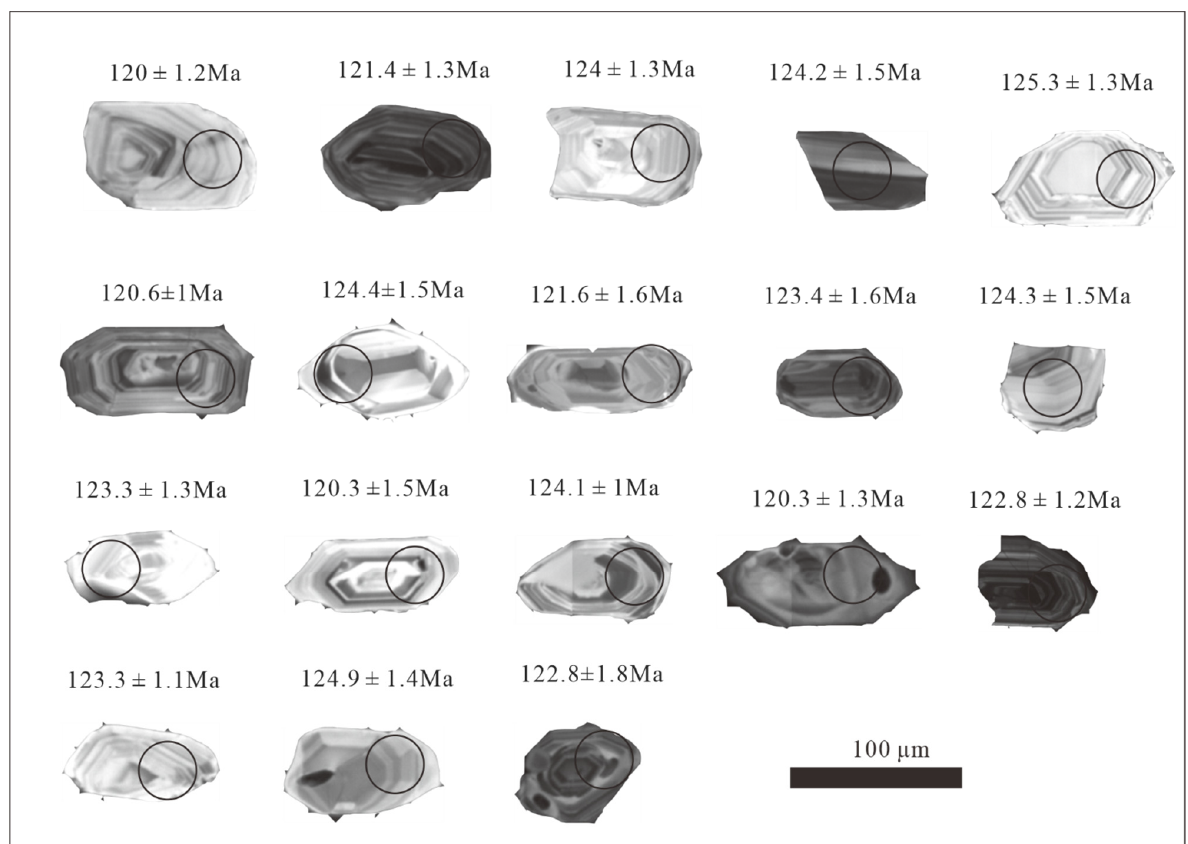
Figure 4. Image of cathode luminescence for determination of zircon.